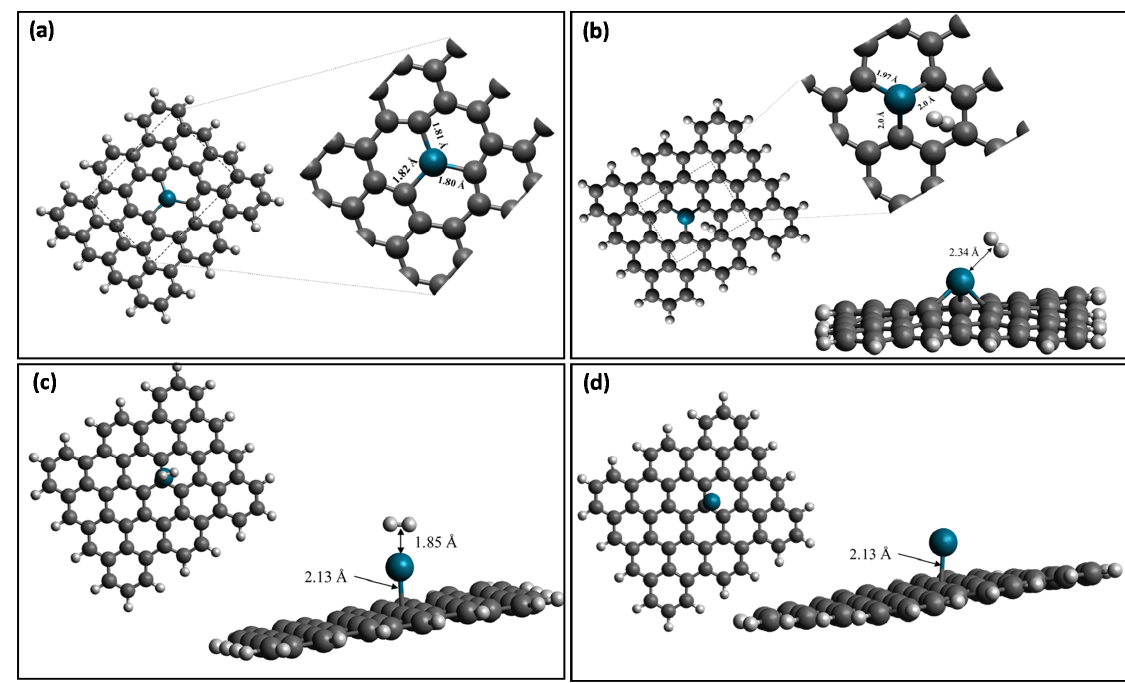
Figure 1. DFT optimized geometries of ( a ) Pd-doped graphene, ( b ) Pd-doped graphene-H 2 , ( c ) Pd-decorated graphene, ( d ) Pd-decorated graphene-H 2 .